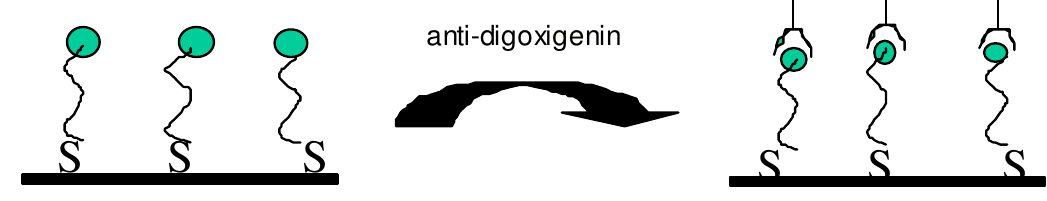
Figure 2b. Specific interaction between the digoxigenin and